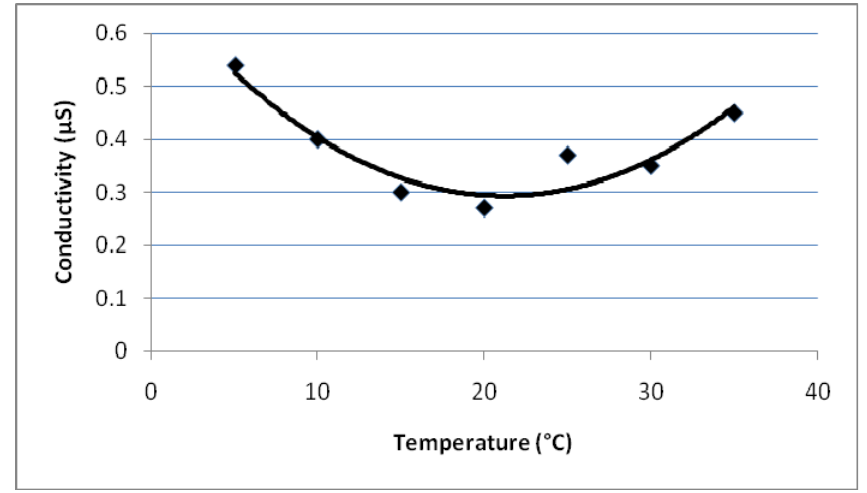
Figure 14. Conductivity vs. temperature change of PMMA with dopant (LiClO